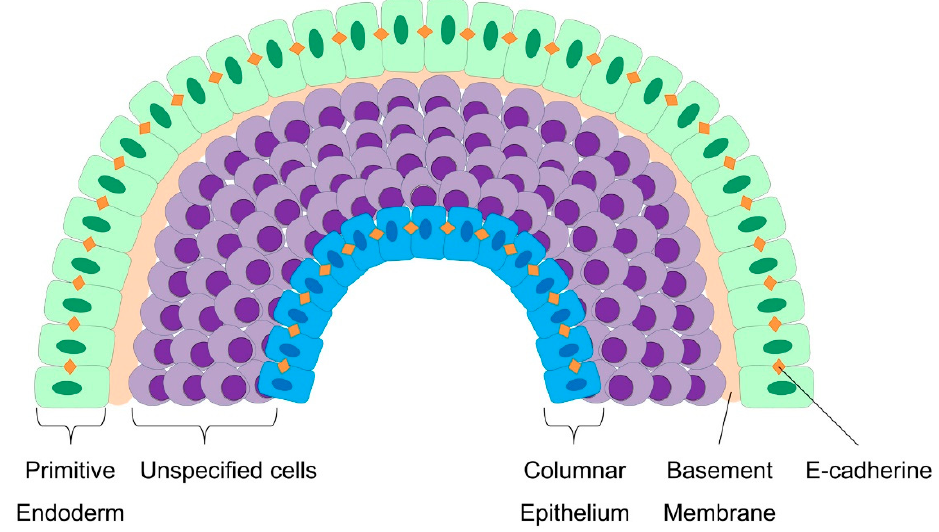
Figure 3. Cellular patterning during embryoid body formation. Around day 2, cells on the surface of the EB form a layer of primitive endoderm which exhibits an epithelial morphology with an increased expression of E-cadherin and a sensitive response to FGF signaling. These cells deposit a basement membrane which is rich in laminin and collagen IV. Cells adjacent to the basement membrane receive survival signals, whereas cells without contact undergo caspase-dependent apoptosis. Cavitation inside the EB forms a yolk sac-like structure and results in the formation of a columnar epithelium. Cells between the primitive endoderm and the columnar epithelium are highly responsive to different signaling pathways, including Wnt, Nodal, and BMP signaling.